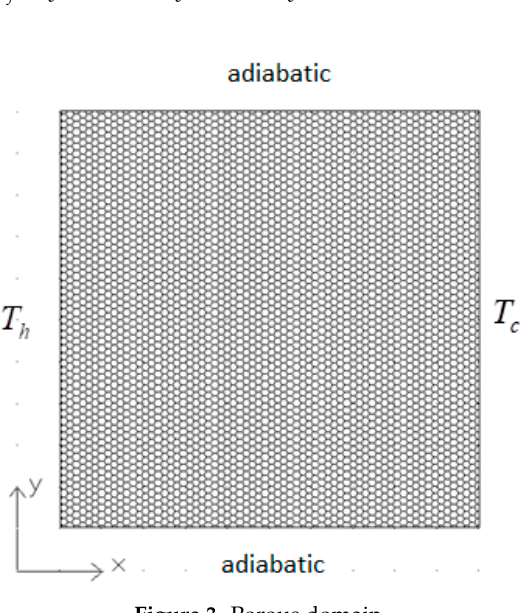
Figure 3. Porous domain.